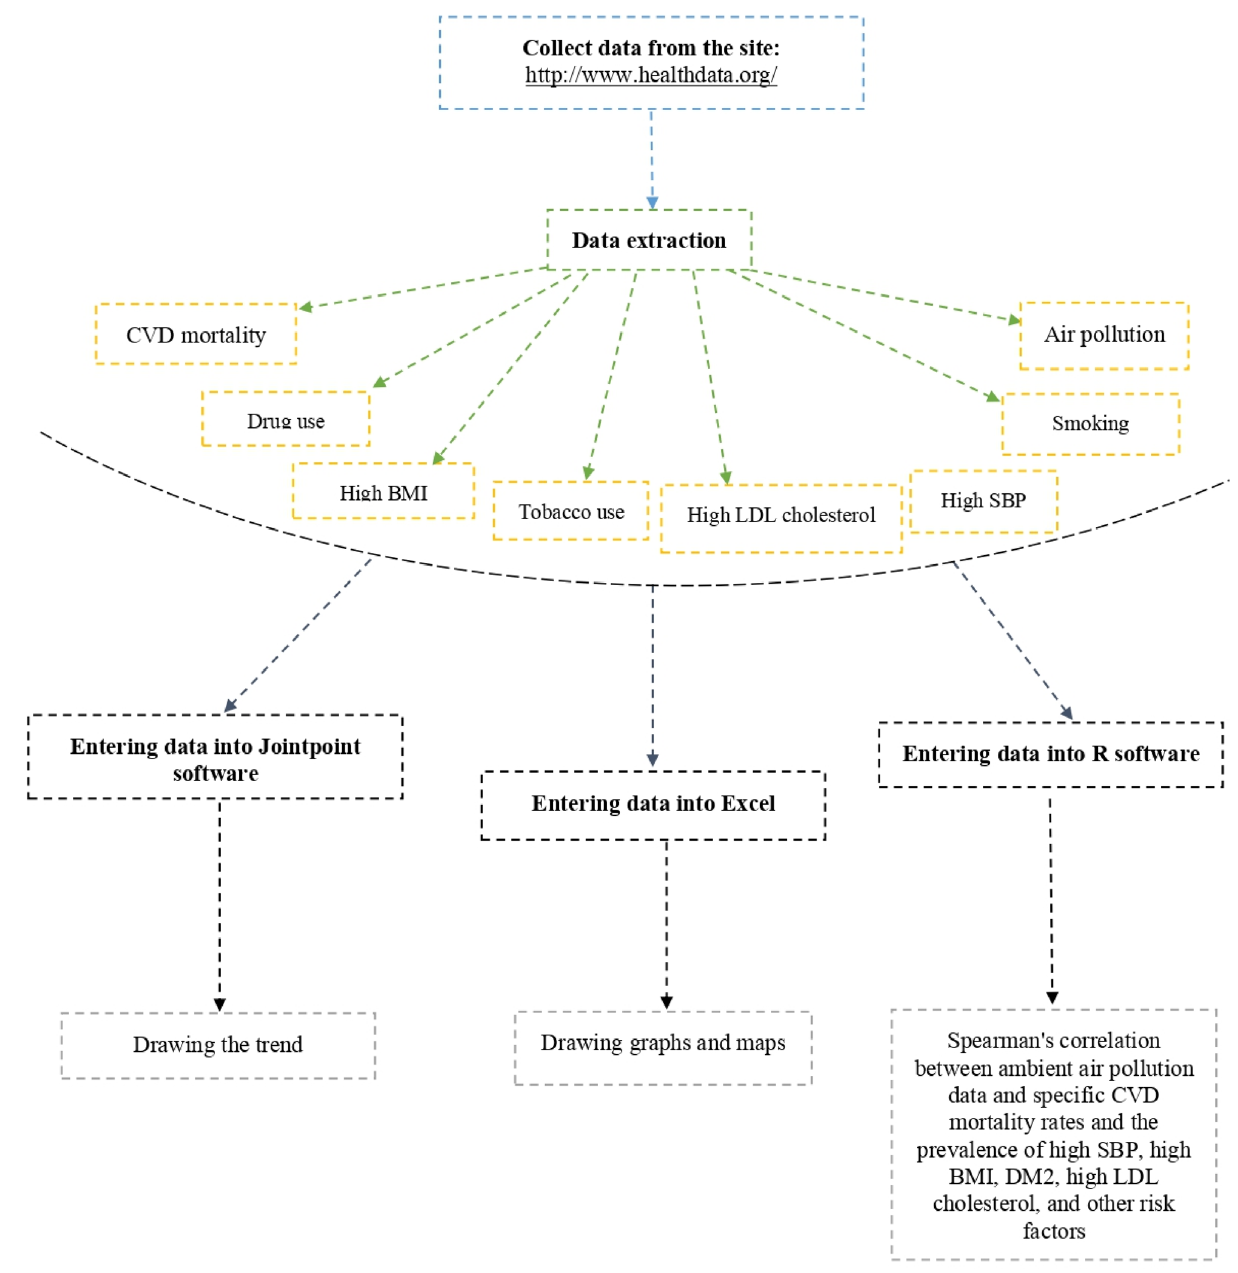
Figure 1. Detail of the plan of the